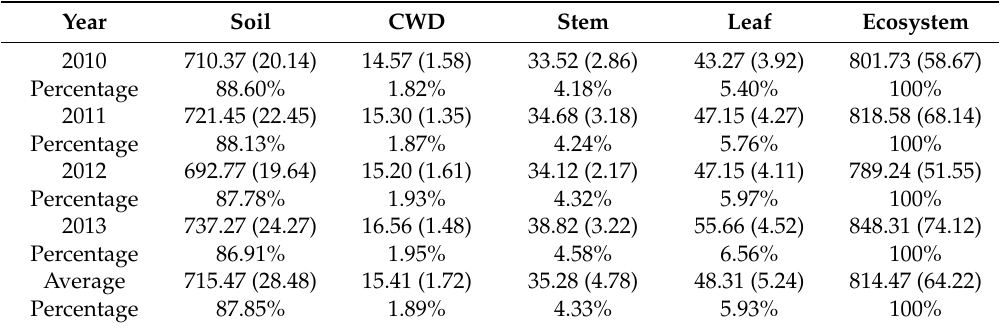
Figure 5. Daily mean soil, CWD, stem, leaf, and total ecosystem respiration in the L. principis-rupprechtii forest during 2010–2013. Error bars are based on 0.5 h soil temperatures and air temperatures as experimental unit, respectively ( n = 48). Table 4. Ecosystem respiration, component respiration (g · C · m − 2 · y − 1 ), and percentage (%) during 2010–2013 and the average over four